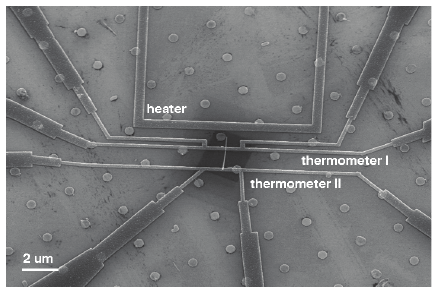
Figure 1: Scanning electron microscope image of a typical nanowire device with heater and thermometer metallic microstrip lines is shown. In a separate measurement, the contact electrodes can be independently used to probe the voltage drop along the nanowire or conductance. Image is of a device similar to the one that is measured.